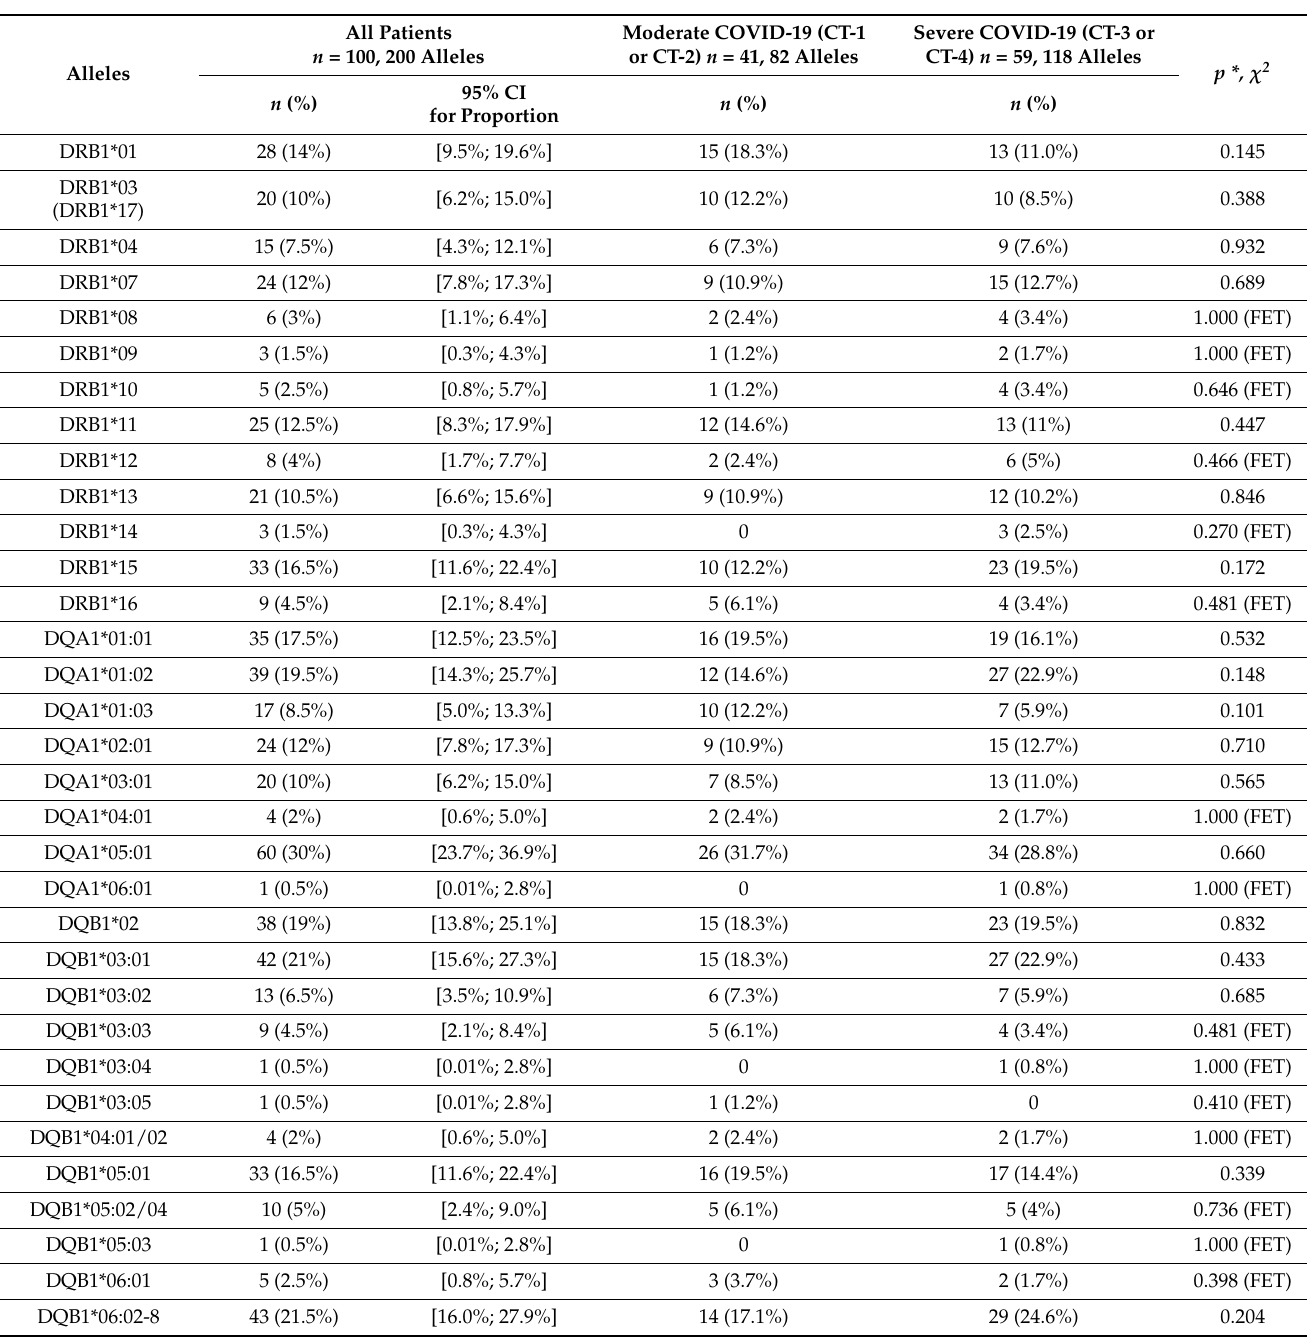
Table 2. HLA typing: frequencies of alleles of class II HLA genes in the entire cohort and in the CT